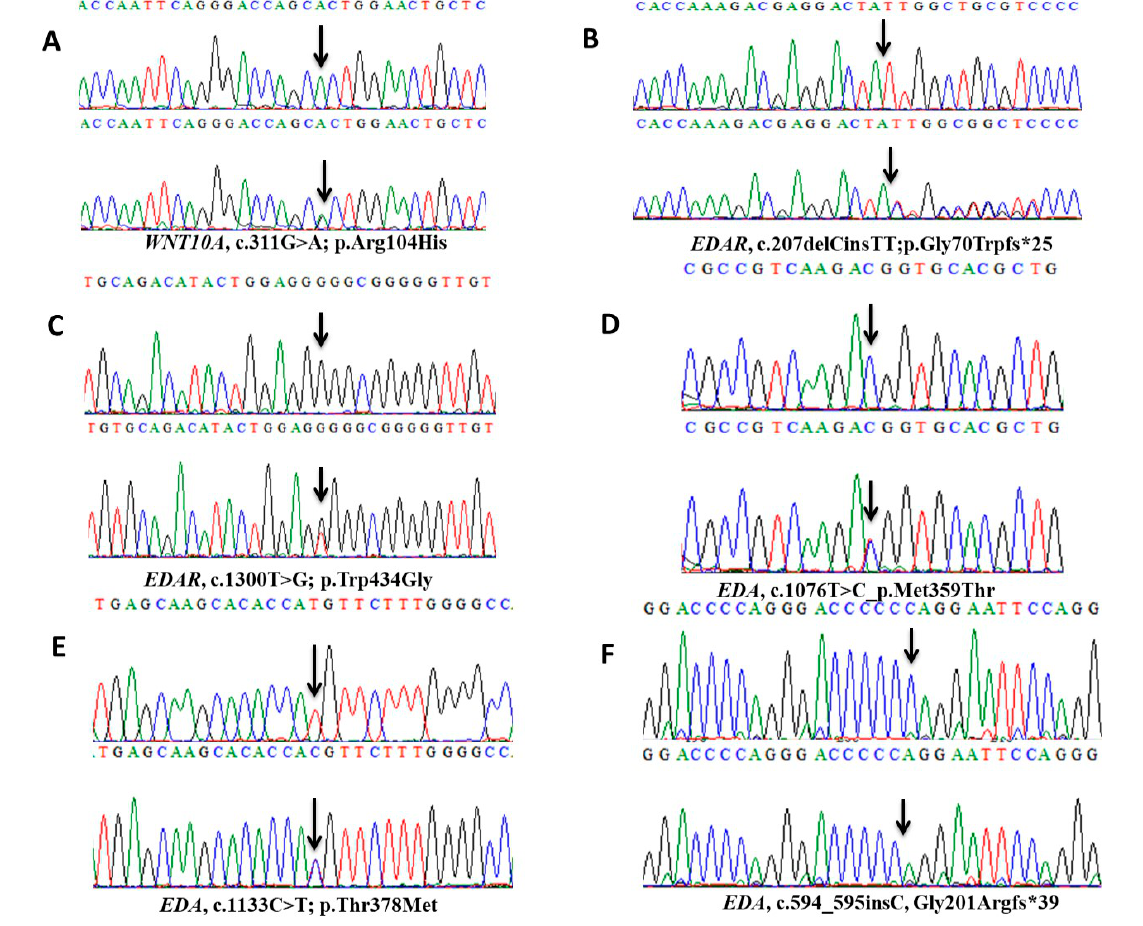
Figure 2. Sequence analysis of WNT10A , EDAR , and EDA variants. ( A ) Panel A shows a partial sequence ofexon-4 of WNT10A in an a ff ected member (IV-2) with novel homozygous missense variant (c.311G > A, p.Arg104His) and of an una ff ected heterozygous carrier (III-2) in family A. ( B ) Panel B presents a partial sequence of exon-4 of EDAR in an a ff ected (IV-3) and an una ff ected member (III-1) of family B showing a novel frameshift variant (c.207delinsTT, p.Gly70Trpfs*25), where the homozygous deletion of C nucleotide and the simultaneous insertion of TT nucleotides is evident in the a ff ected member sequence. ( C ) Panel C is showing a partial DNA sequence of exon-12 of EDAR representing a novel missense variant (c.1300T > G, p.Trp434Gly) in an a ff ected member (IV-5) and a heterozygous carrier (III-1) of family C ( D – F ) Three EDA sequence variants are presented in panel D, E and F. Panel D and E are showing missense sequence variants (c.1076T > A, p.Met359Thr; c.1133C > T, p.Thr378Met) in a ff ected members (IV-4) (II-3) and una ff ected carriers (III-2) (I-2) of family D and E, respectively. The panel F is showing a de novo frameshift variant (c.594_595insC, Gly201Argfs*39) in the a ff ected member (II-2) of family Fwhile themother (I-2) of this a ff ected member shows a wild-type sequence in the same panel.